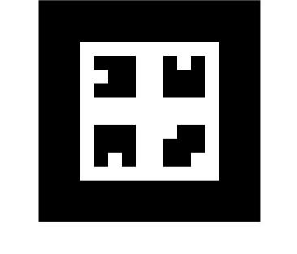
Figure 3. The concept of corners detection